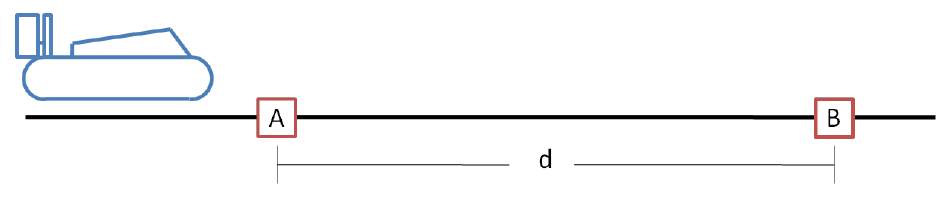
Figure 15. Performance testing of